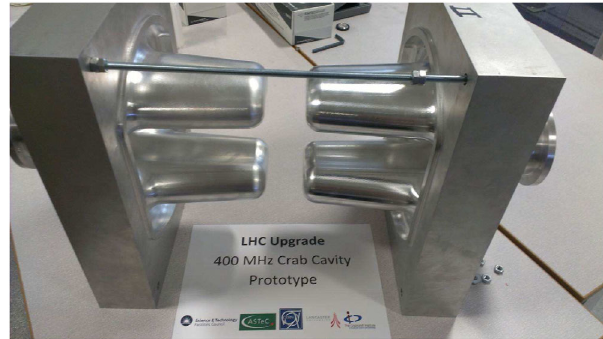
FIG. 22. The Aluminum cavity without the outer can, showing the inner